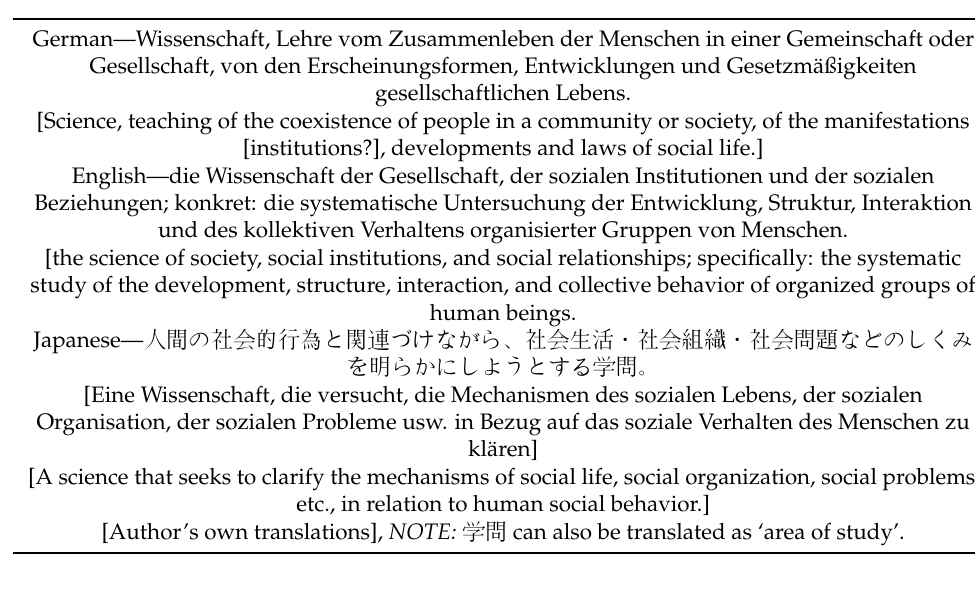
Table A3. Original